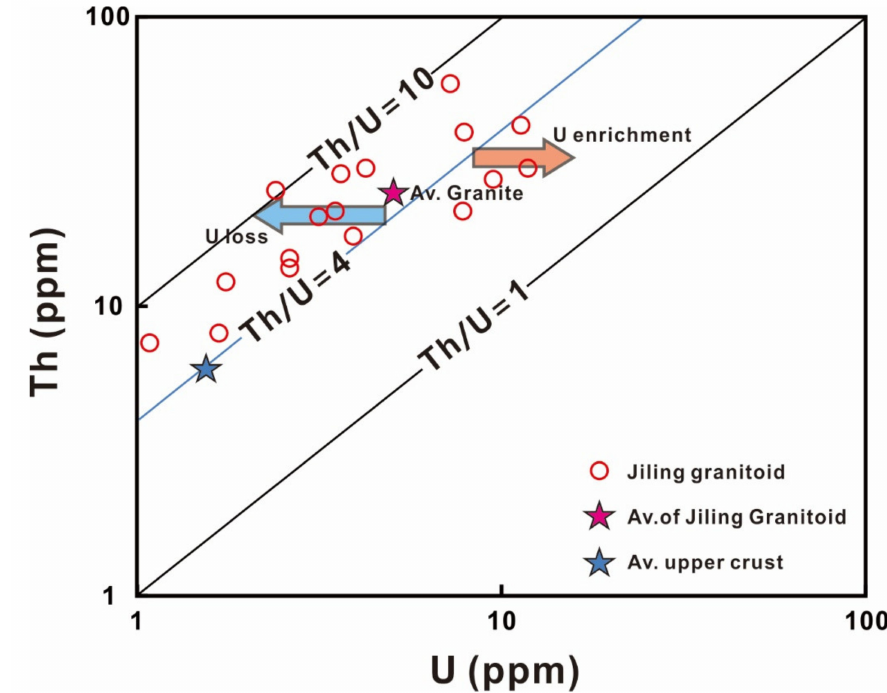
Figure 10. Th vs. U diagram of the Jiling granitoids showing their U and Th enrichment relative to the average upper crust and average granite. Most samples exhibited U depletion compared to the average crust ratio of